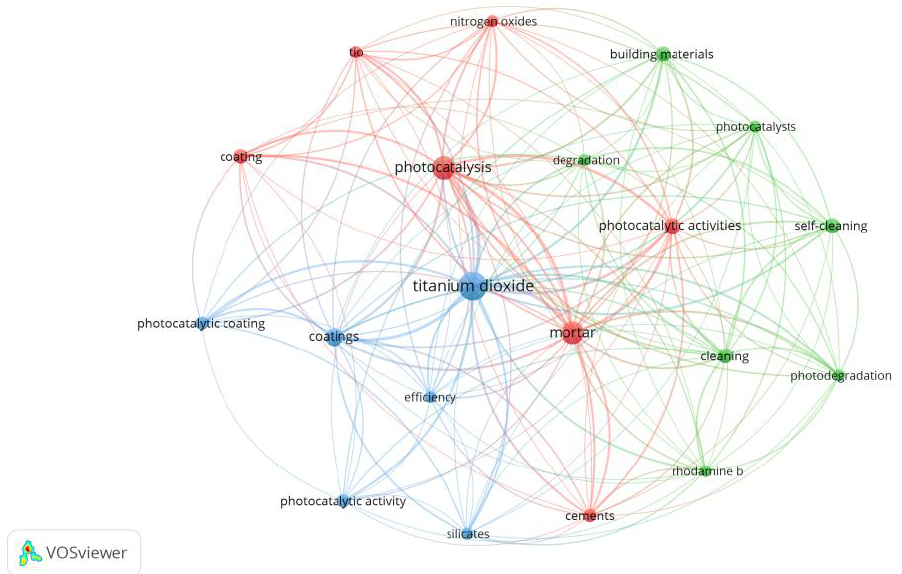
Figure 4. Bibliometric network map referring to the co-occurrence of 20 keywords from the final sample of 34 papers related to self-cleaning ability, depollution effect, antimicrobial effect, and durability.